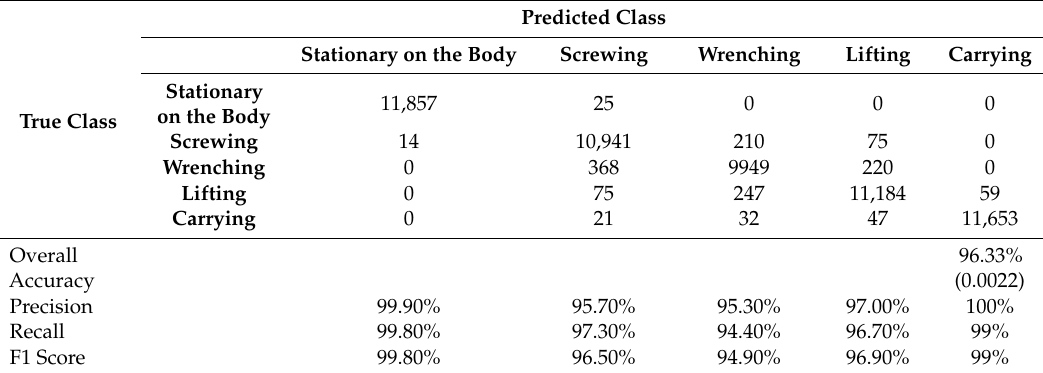
Table 12. Confusion matrix and class report of random forest classifier on Day-2 dataset.